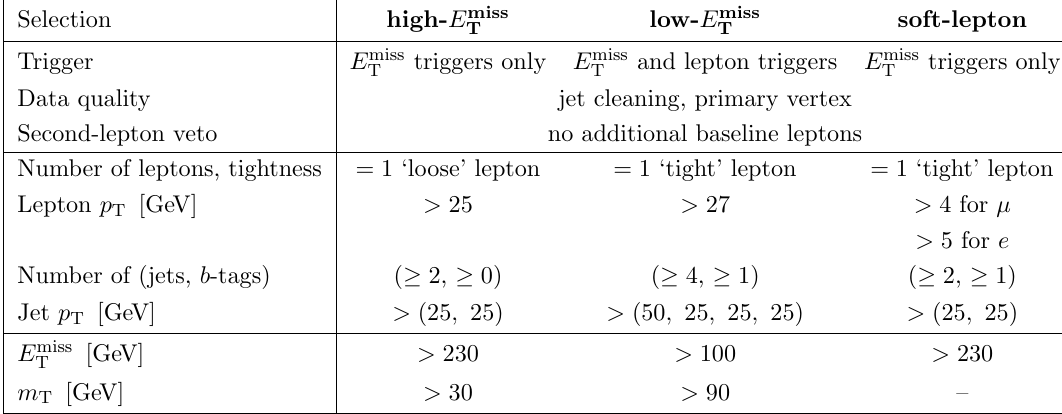
Table 4 . Preselection criteria used for the high- E miss regions (middle) and the soft-lepton signal regions (right). For the soft-lepton selection, p T is required for electrons. List values are provided in between